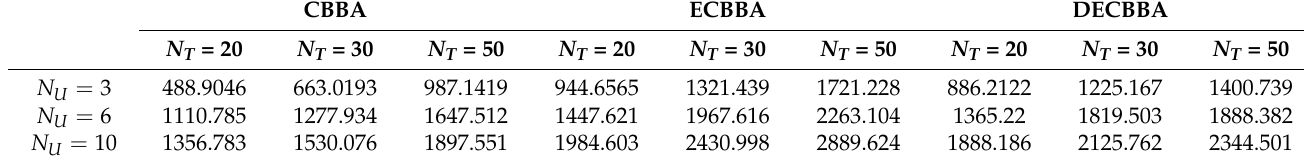
Table 7. Global utility with different numbers of UUVs and tasks.